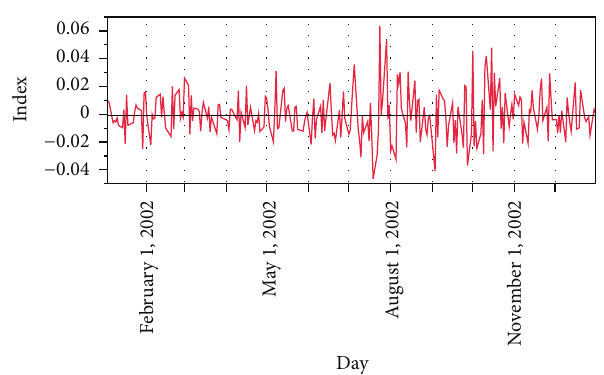
Figure 3: Processed data for year 2002 of